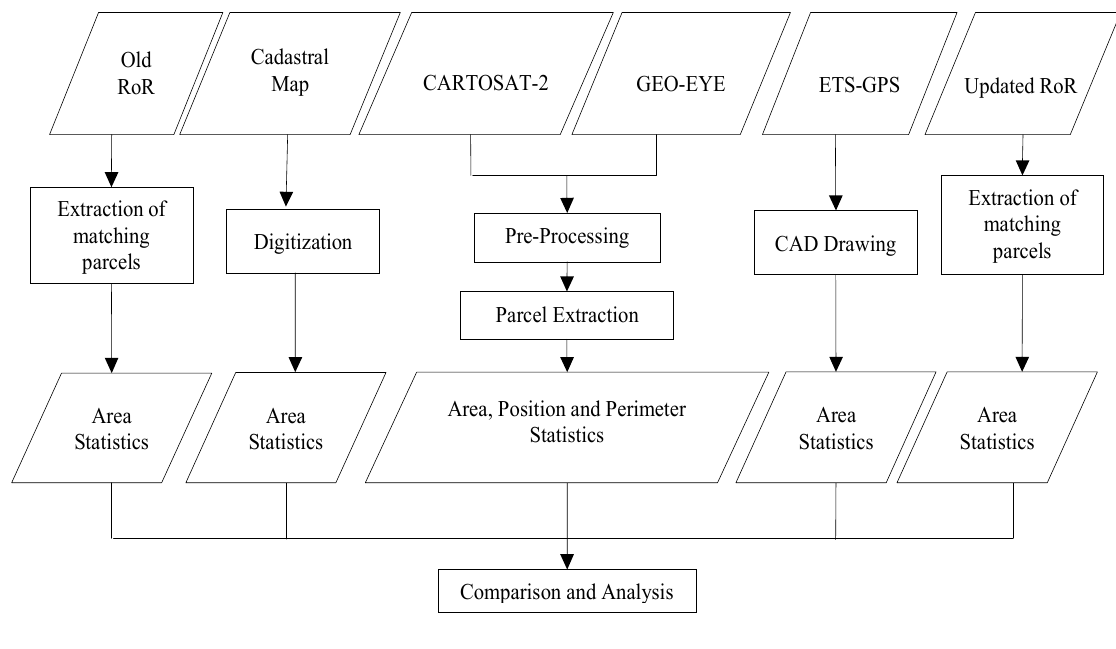
Figure 3. Methodology